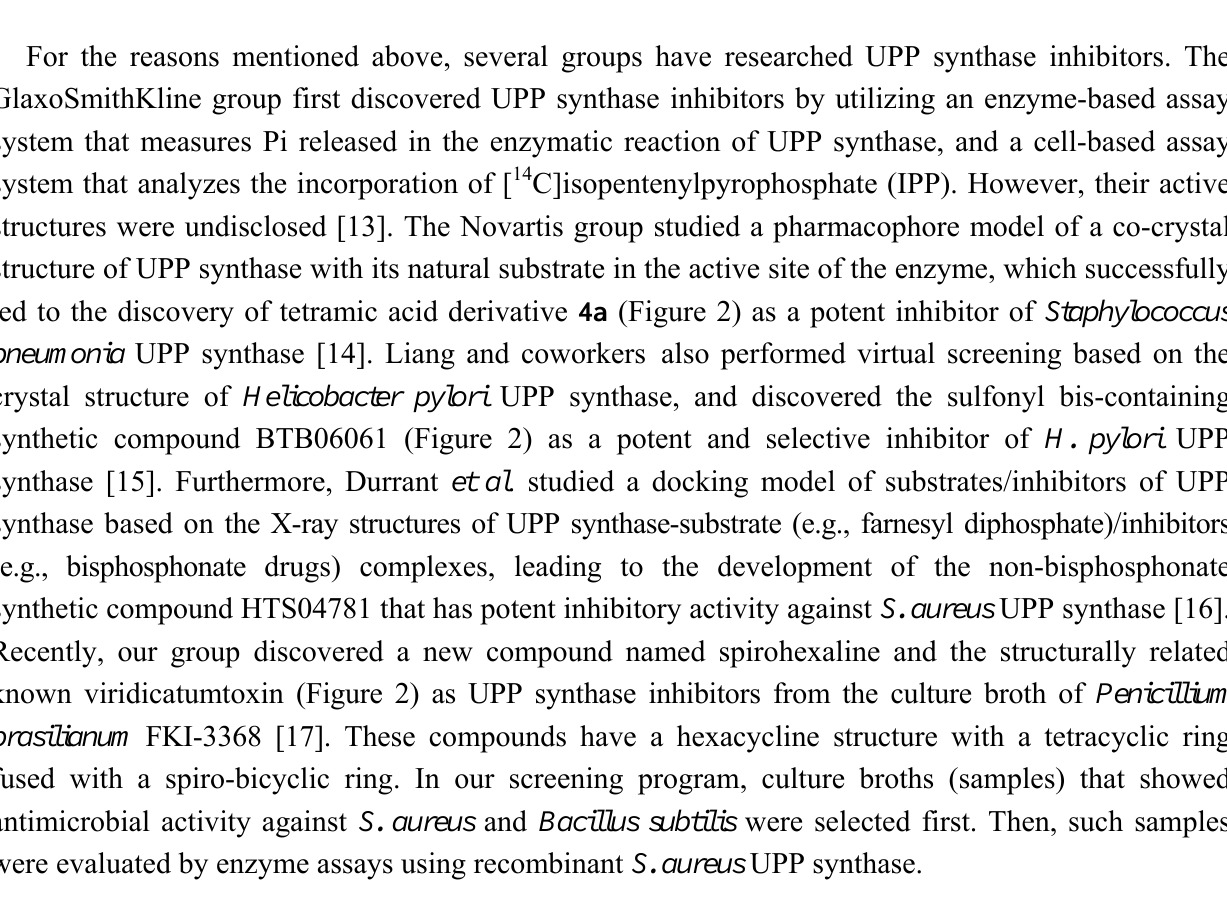
Figure 2. Structures of tetramic acid 4a, BTB06061, HTS04781, spirohexaline, and